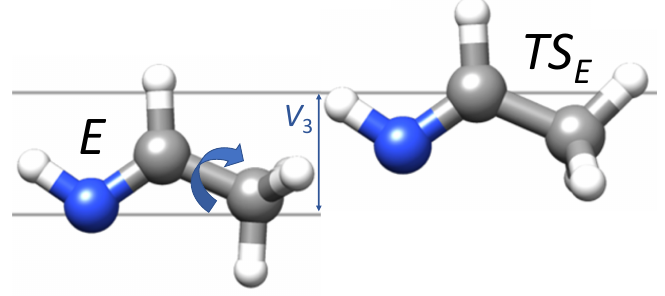
Figure 2. Methyl internal rotation in